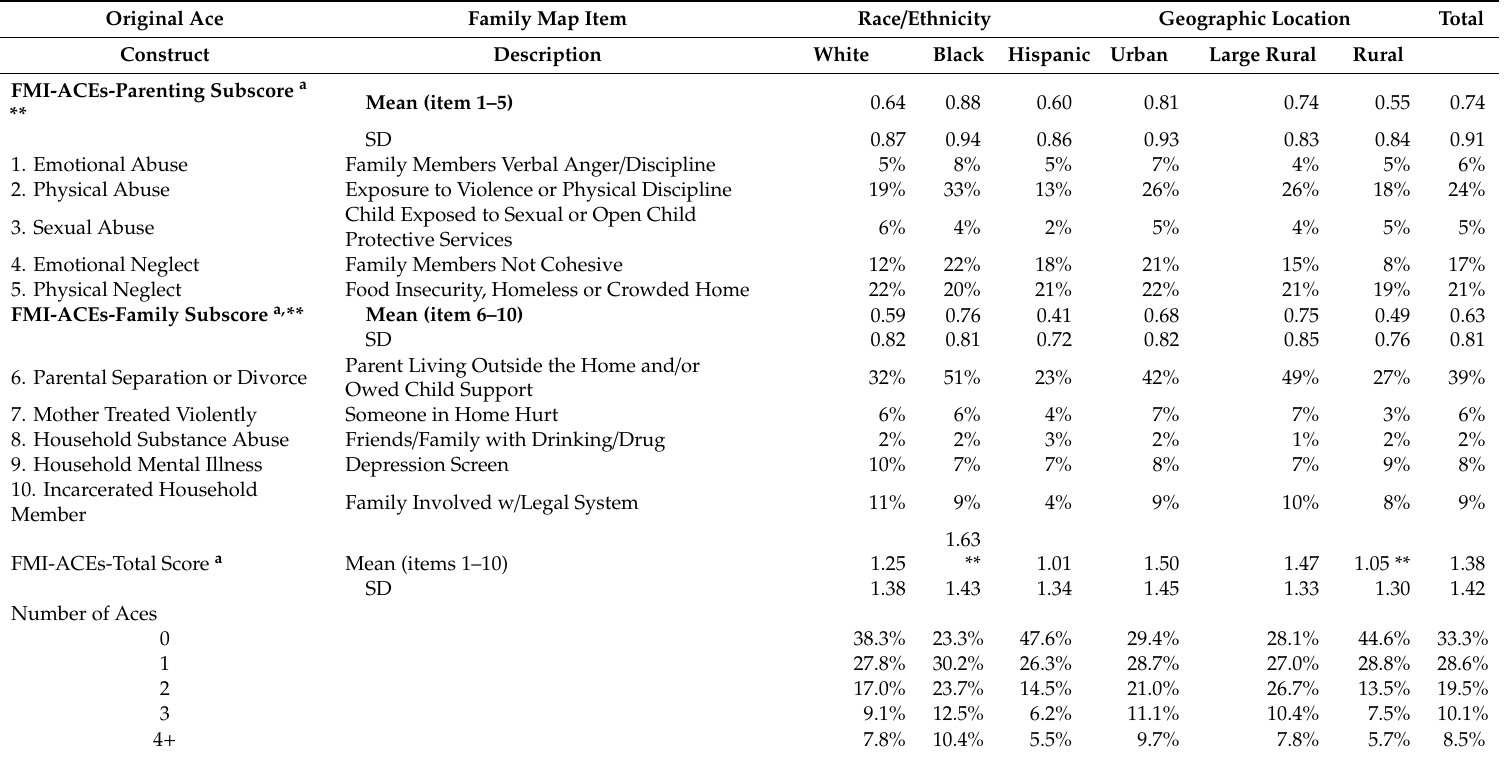
Table 2. Adverse childhood experiences from family map inventories with unadjusted percent and